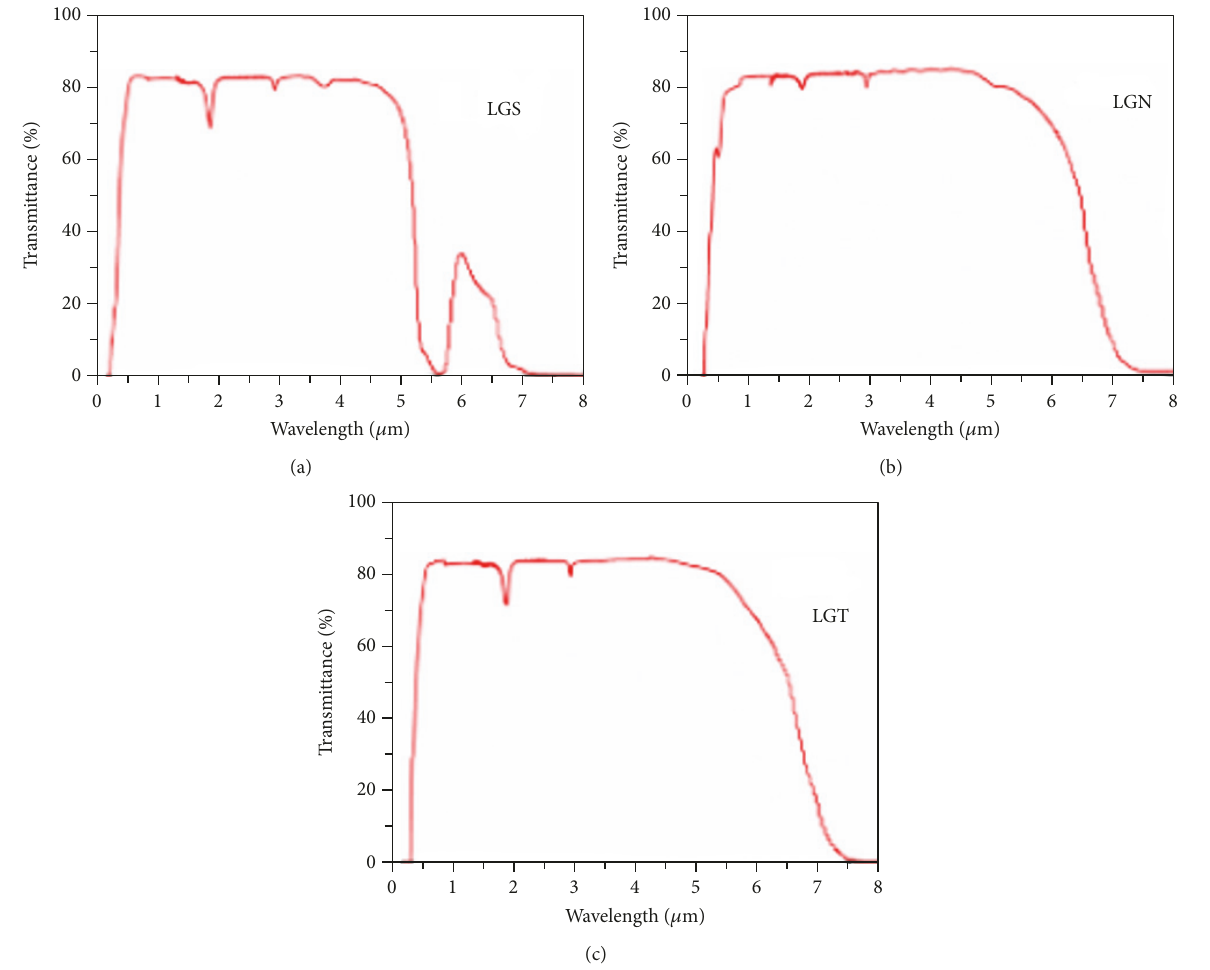
Figure 3: The transmission spectra of (a) LGS, (b) LGN, and (c) LGT